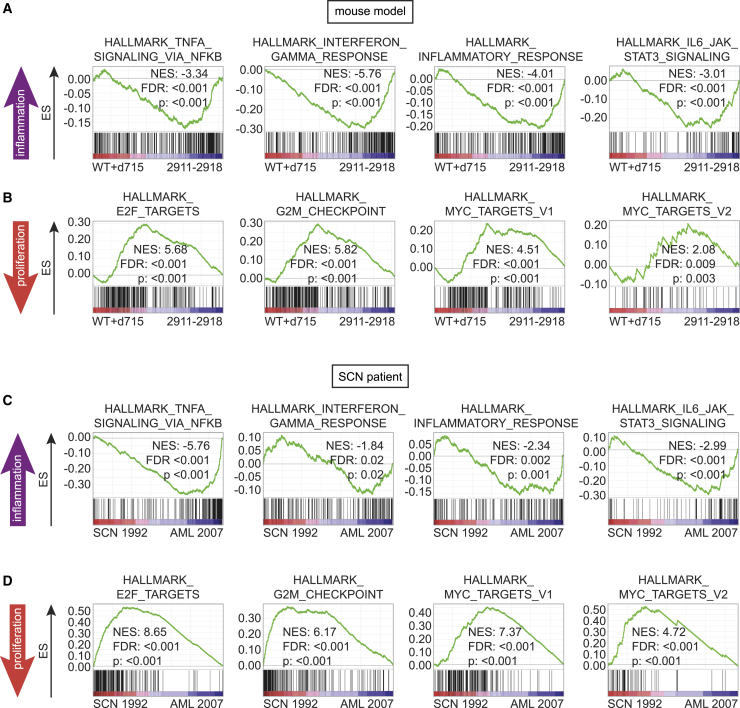
Leukemic Progression of the d715-RHD Mouse Model and SCN (SCN-AML) Is Associated with Increased Inflammatory and Decreased Proliferative Signaling(A and B) GSEA analyses comparing control (WT and d715 transcriptional data combined, n = 2) versus leukemic (tertiary recipients 2911–2918, n = 8) LK/c-Kit+ cells showing (A) upregulation of inflammatory signaling and (B) downregulation of proliferative pathways in leukemic mice.(C and D) GSEA comparing CD34+ cells from the SCN phase (1992) and the SCN-AML phase (2007), showing (C) increased inflammatory pathways and (D) downregulated proliferation signatures.ES, enrichment score; NES, normalized ES; FDR, false discovery rate. See also Figure S3 and Tables S1 and S2.